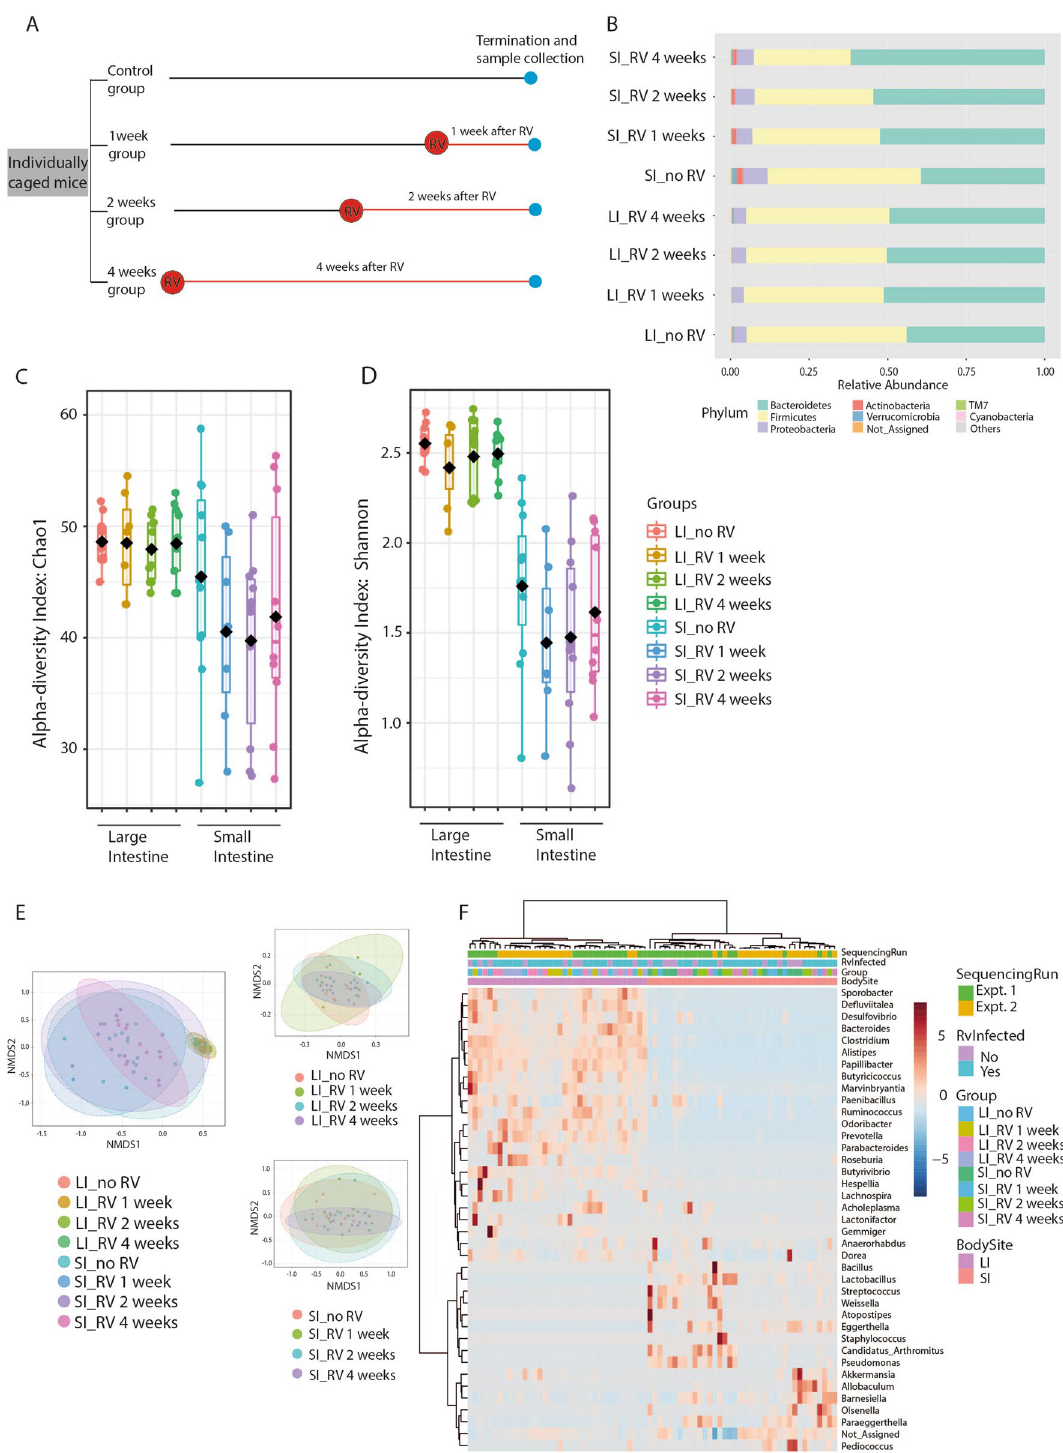
Figure 1. Dynamic of the intestinal microbiota composition upon RV infection. ( A ) Image illustrating the study design. ( B ) Taxonomic composition of community using Stacked Bar plot. Relative abundance of the top 8 Phylum in SI and LI in merged samples to groups (SI and LI; uninfected and 1, 2, and 4 weeks post infection for each niche). ( C , D ) Alpha diversity at the bacterial Genus level represented by Chao1 index ( C ) and Shannon index ( D ) represented as boxplot. Each boxplot represents the diversity distribution of the group. ( E ) Beta diversity at the bacterial Genus level determined by Nonmetric Multidimensional Scaling (NMDS). ( F ) Heat- map depicting the abundance of major bacterial taxa at the Genus level. Results are from a total of 76 intestinal samples (38 from SI and 38 from LI) from two independent